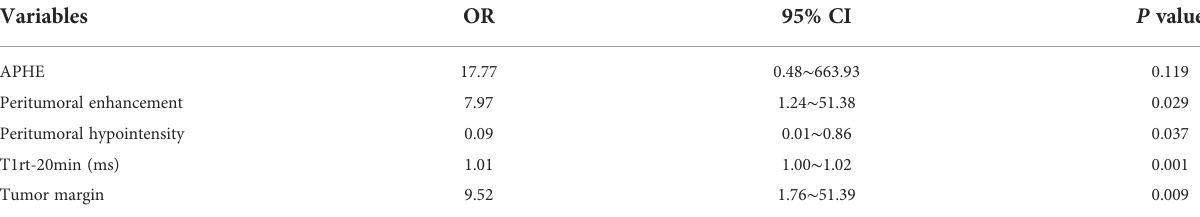
TABLE 4 Multivariable analyses of preoperative Gd-EOB-DTPA enhanced MRI features in prediction of Ki-67 expression.